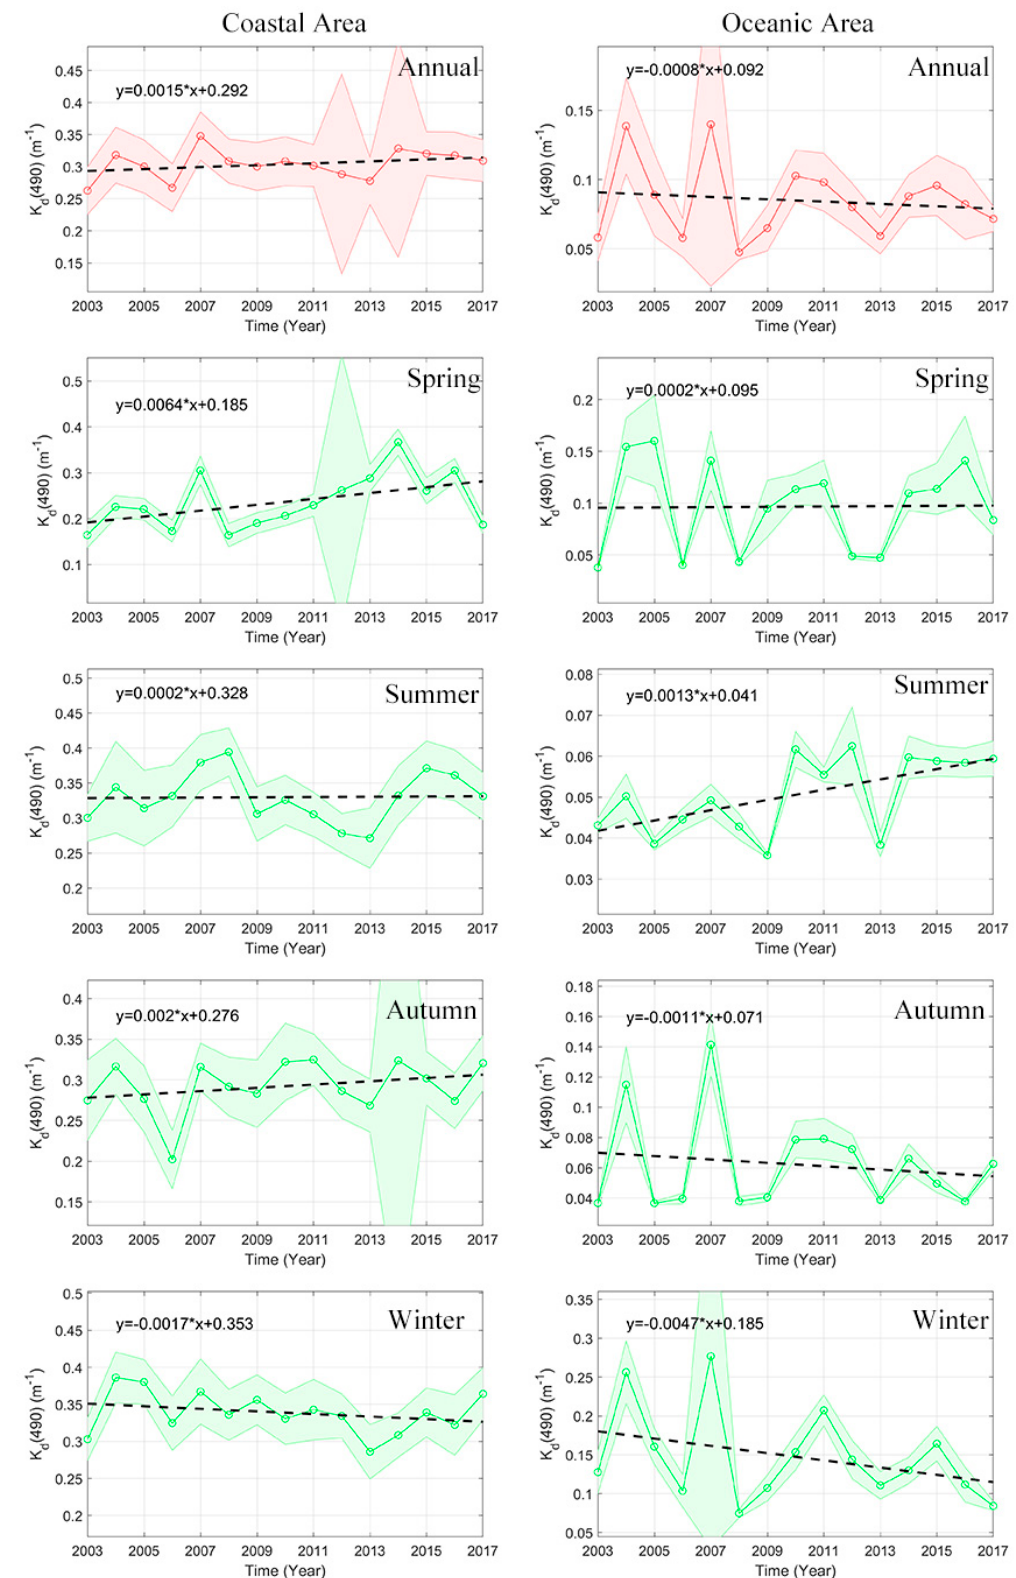
Figure 4. Annual and seasonal average K d (490) of the PRE waters between 2003 and 2017.